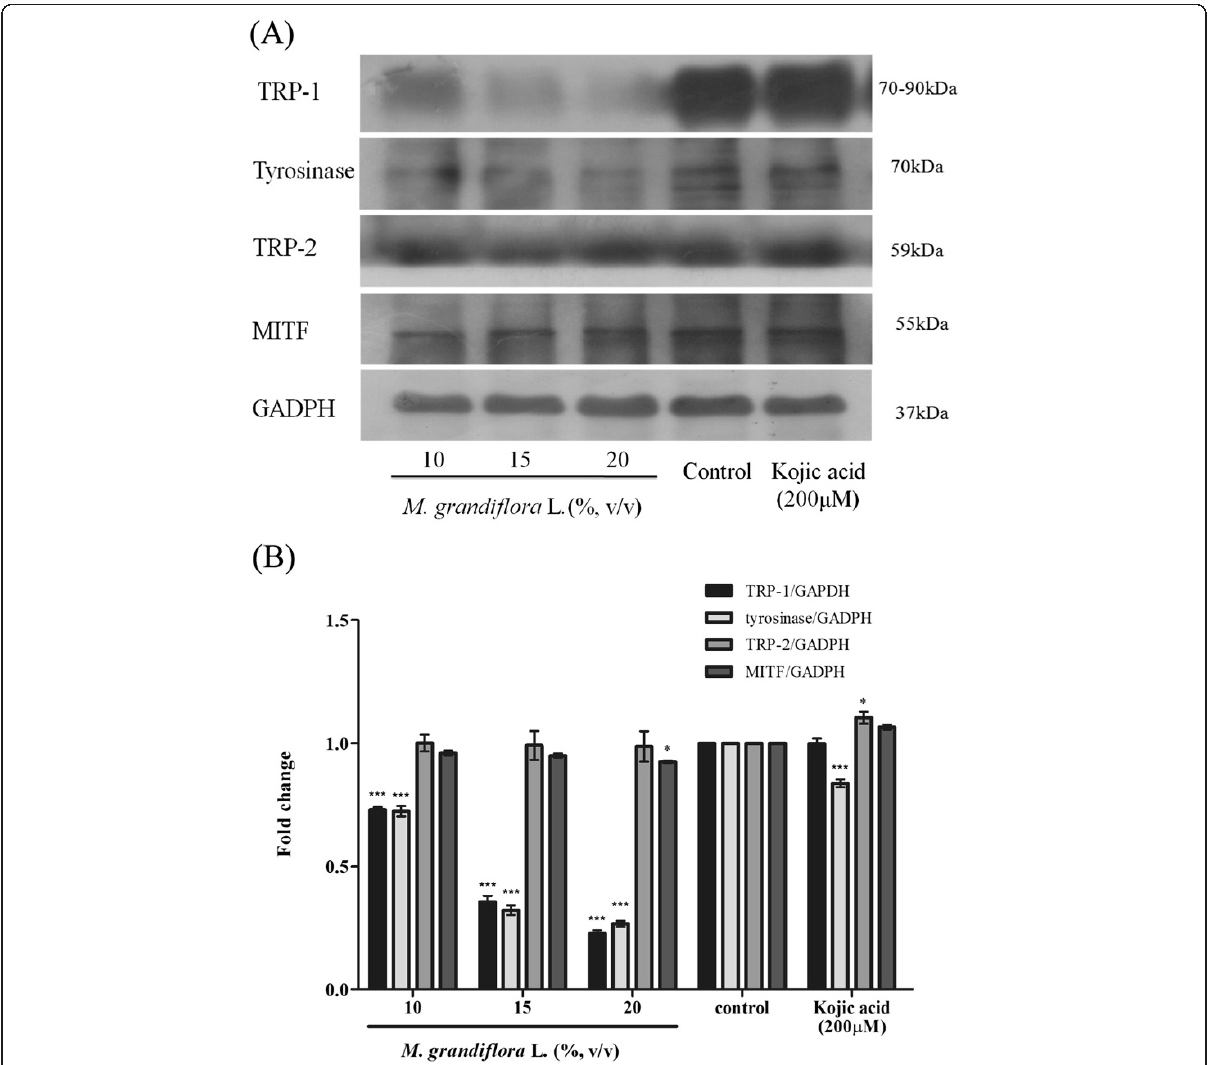
Figure 3 Effect of M. grandiflora L. flower extract on melanogenesis-related proteins expression. ( A ) B16F10 cells were cultured with α -MSH (100 nM) for 24 h and then treated with various concentration of the flower extract (10, 15, 20%; v/v) or kojic acid (200 μ M) for another 24 hr. Then the content of cellular MITF, tyrosinase, TRP-1 and TRP-2 proteins were analyzed by western blotting assay. ( B ) The relative amounts of MITF, tyrosinase, TRP-1 and TRP-2 compared to total GAPDH were calculated and analyzed by Multi Gauge 3.0 software and the values represented the mean of triplicate